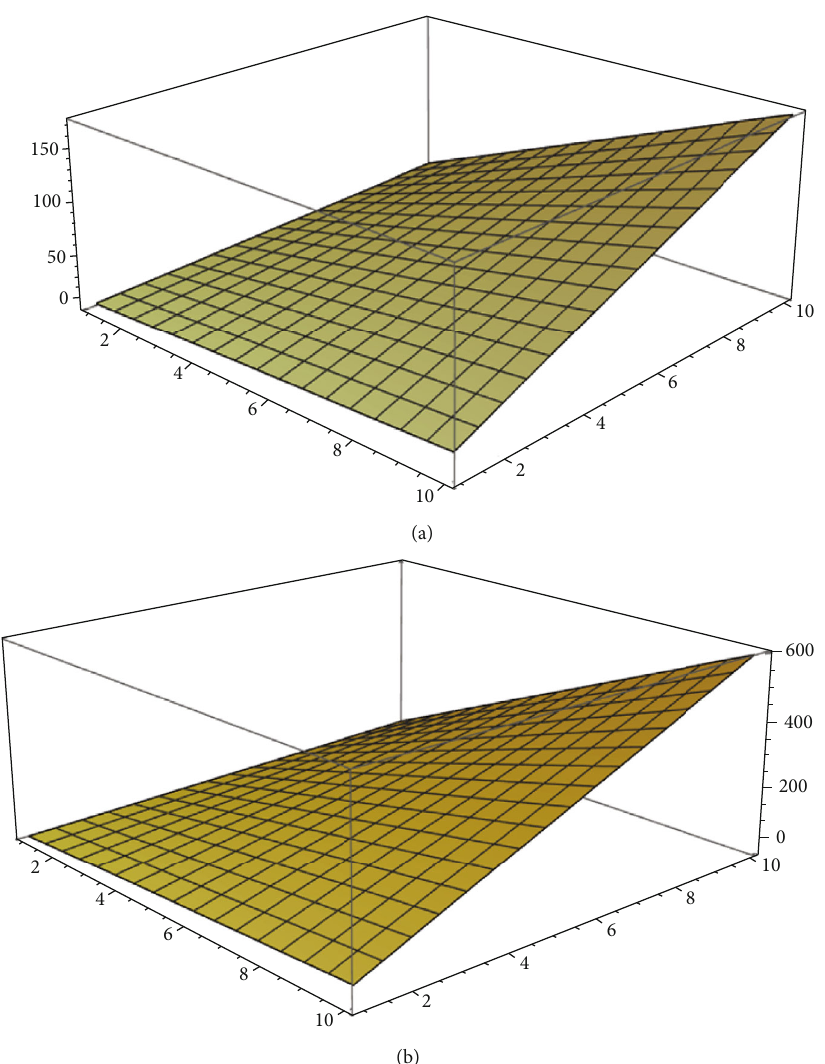
Figure 5: (a)Ve-deg-based R-index and (b) ev-deg-based